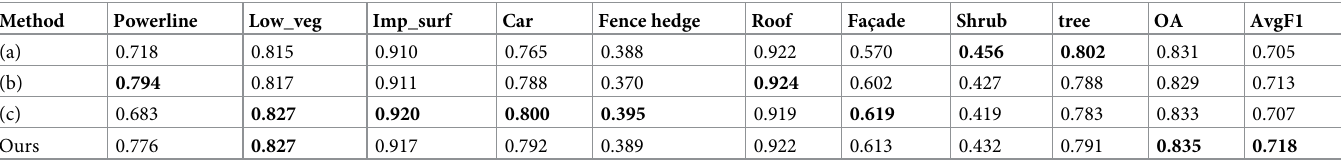
Table 4. The quantitative results using different features on local